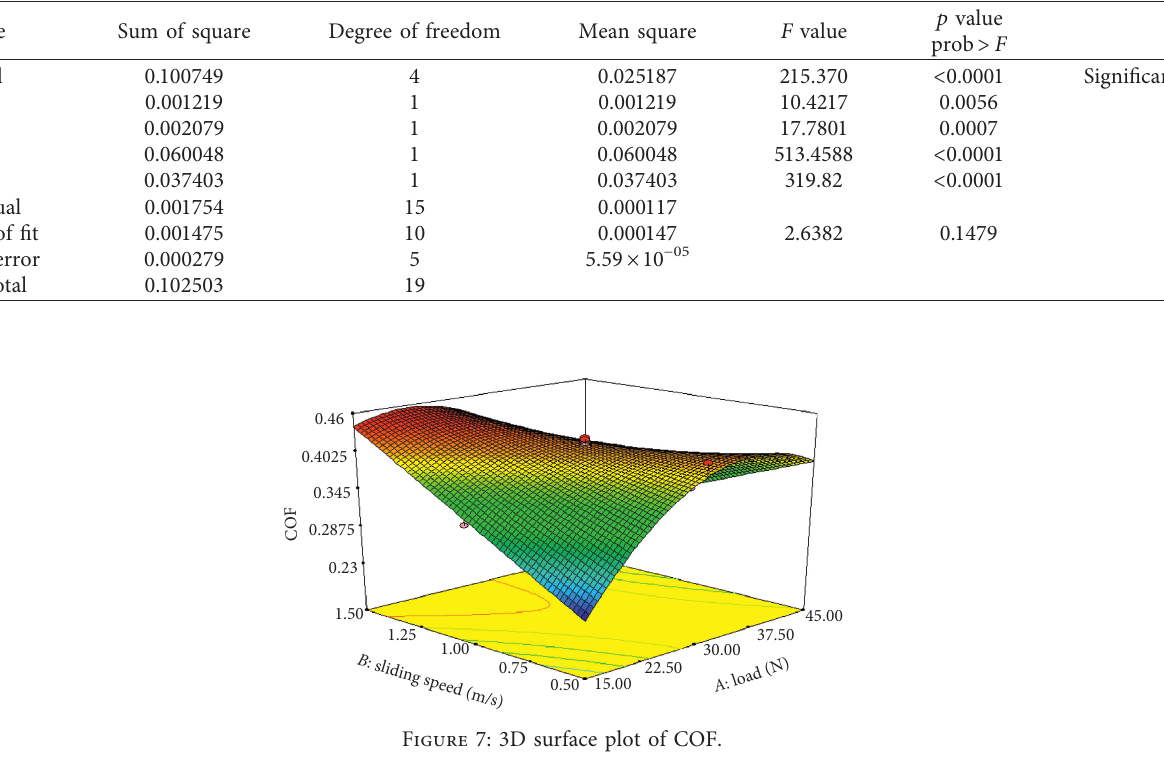
Table 4: ANOVA for COF.